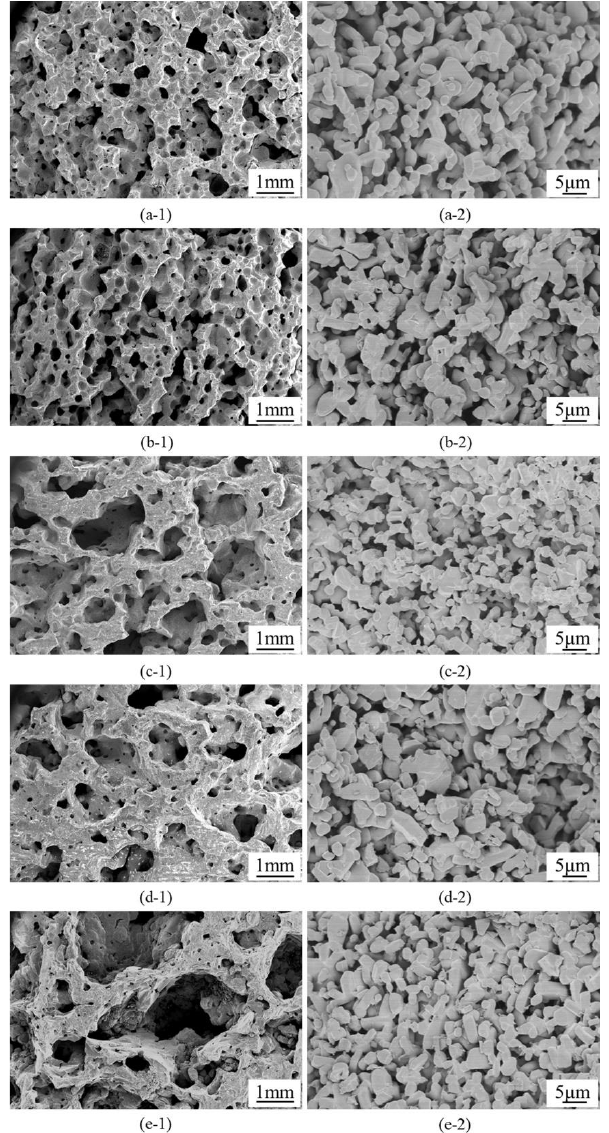
Figure 2. SEM images of SiC porous ceramics prepared with different H 2 O 2 additions: ( a-1 ) 1st pore morphology with 5 wt.% H 2 O 2 ; ( a-2 ) 2nd pore morphology with 5 wt.% H 2 O 2 ; ( b-1 ) 1st pore morphology with 7.5 wt.% H 2 O 2 ; ( b-2 ) 2nd pore morphology with 7.5 wt.% H 2 O 2 ; ( c-1 ) 1st pore morphology with 10 wt.% H 2 O 2 ; ( c-2 ) 2nd pore morphology with 10 wt.% H 2 O 2 ; ( d-1 ) 1st pore morphology with 12.5 wt.% H 2 O 2 ; ( d-2 ) 2nd pore morphology with 12.5 wt.% H 2 O 2 ; ( e-1 ) 1st pore morphology with 15 wt.% H 2 O 2 ; ( e-2 ) 2nd pore morphology with 15 wt.% H 2 O 2 .